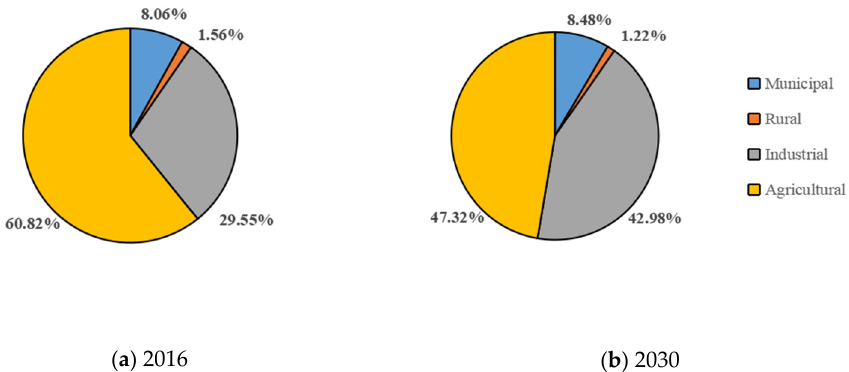
Figure 6. The percentages of water demand for the socioeconomic water use in 2016 ( a ) and 2030 ( b ).